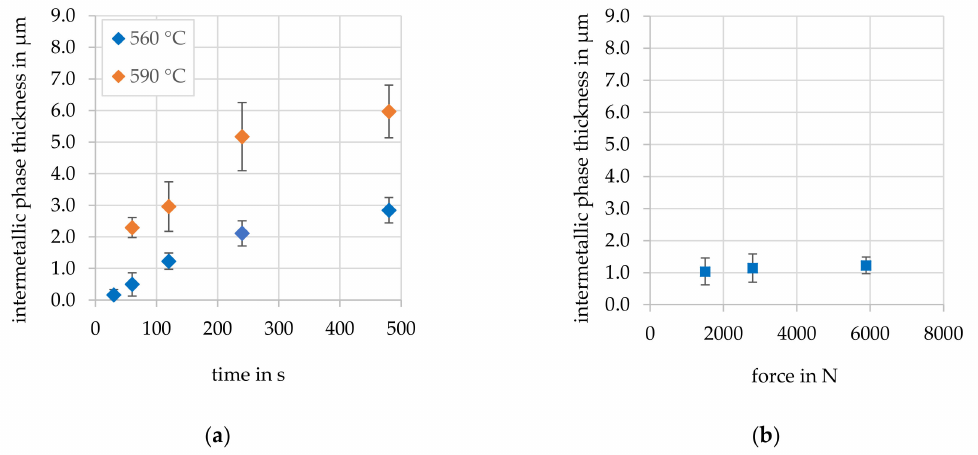
Figure 6. Development of the intermetallic phase seam thickness with indication of the standard deviation as a function of ( a ) forming time and forming temperature for a force of 5890 N, ( b ) force for a temperature of 560 ◦ C and a forming time of 120 s.